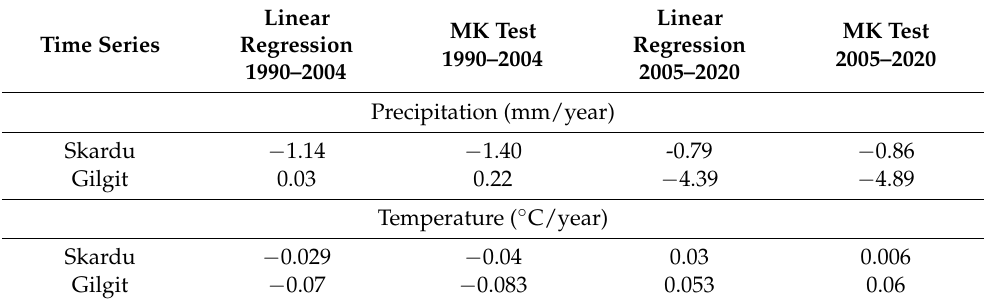
Table 3. MK trend test (95% significance) and linear regression of winter precipitation and mean summer temperature from 1990–2004 and